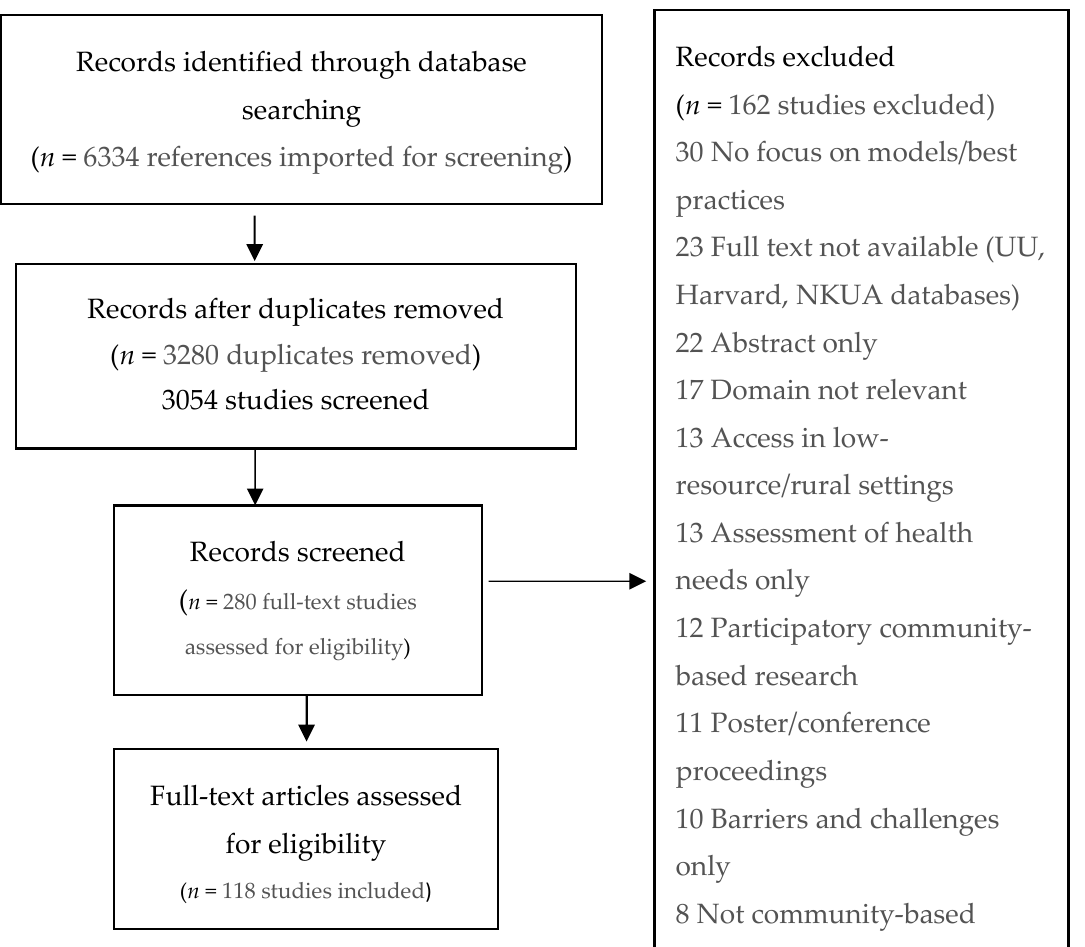
Figure 1. PRISMA flow diagram for Mig-HealthCare systematic database search.